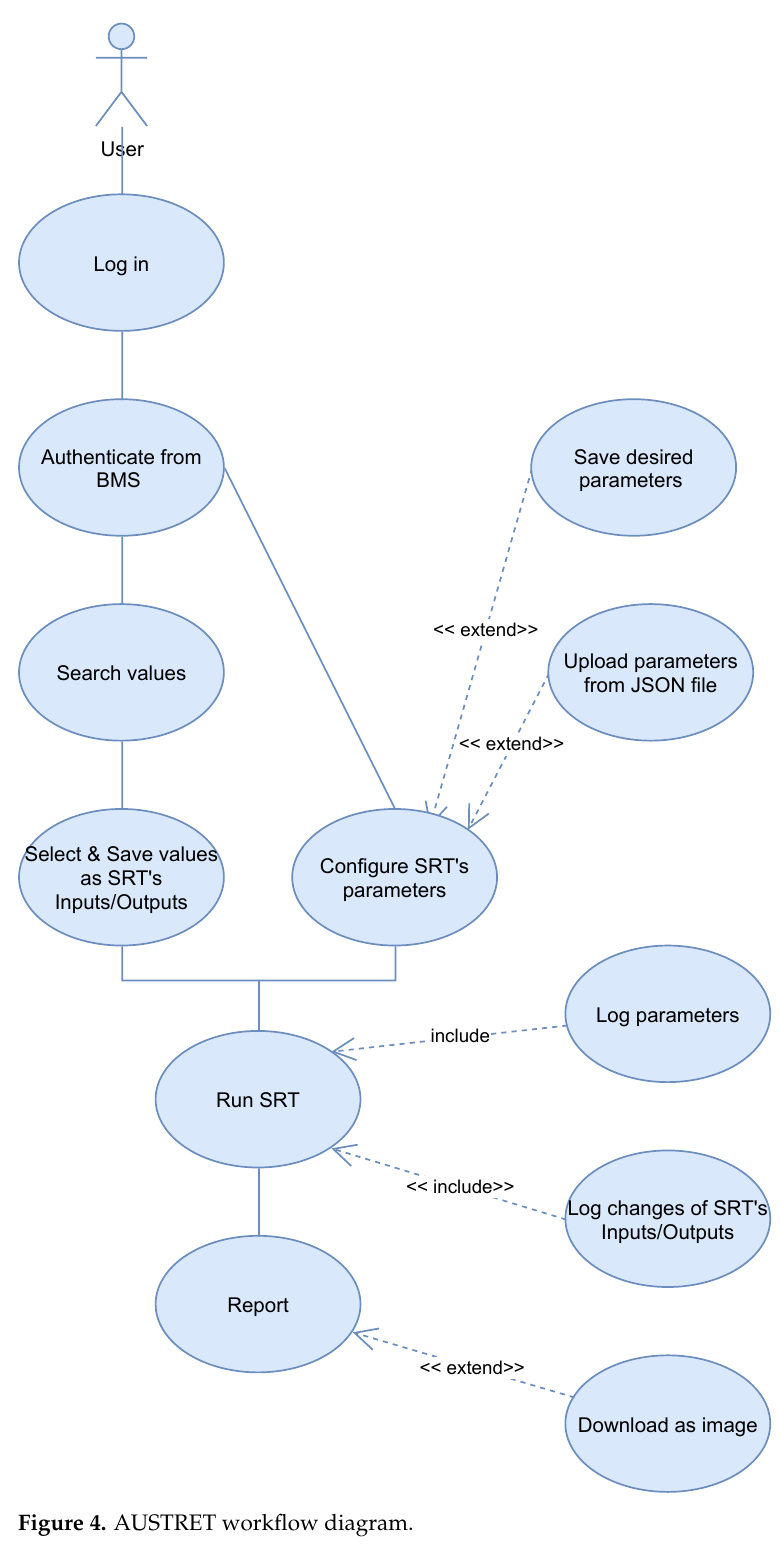
Figure 4. AUSTRET workflow